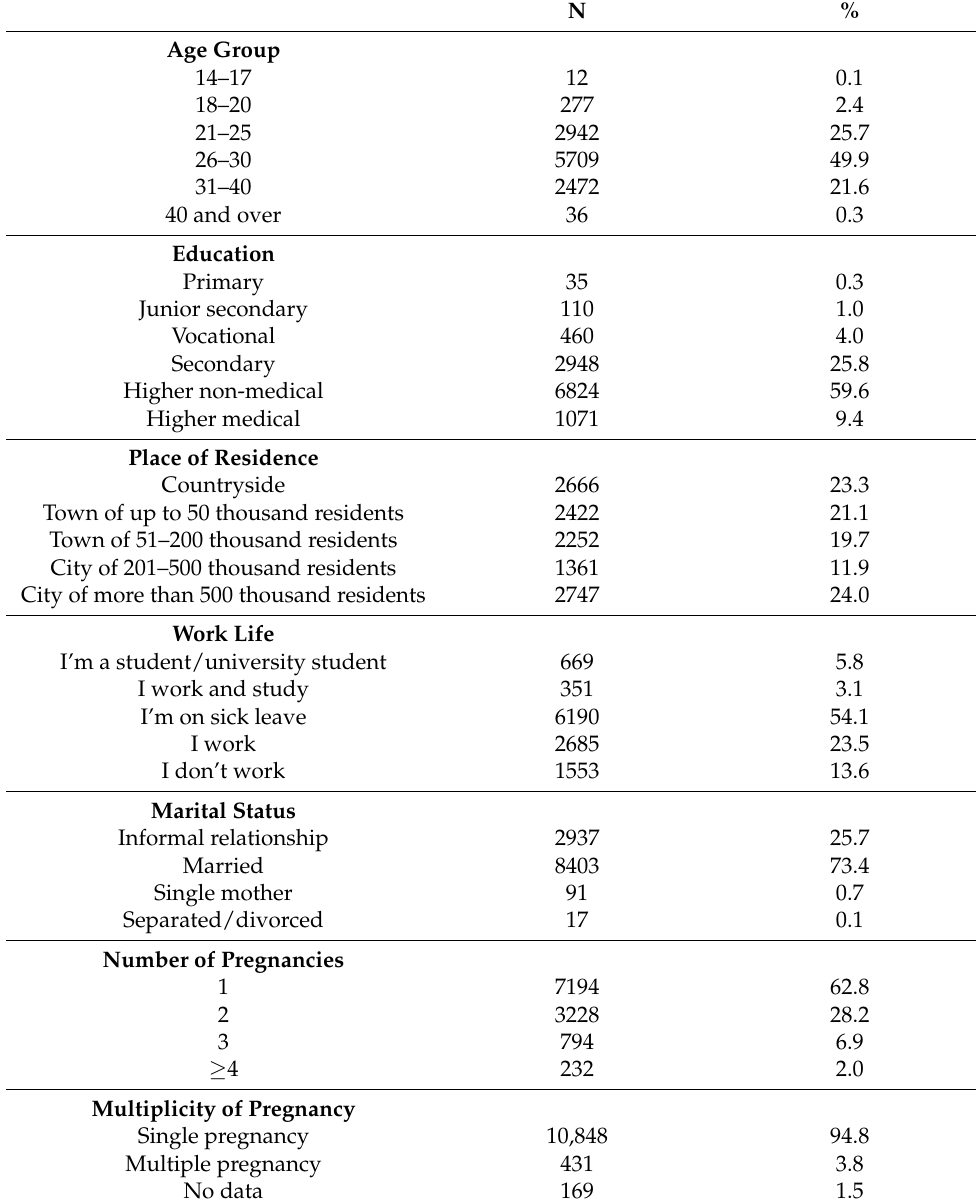
Table 1. Characteristics of participants in the study (n =